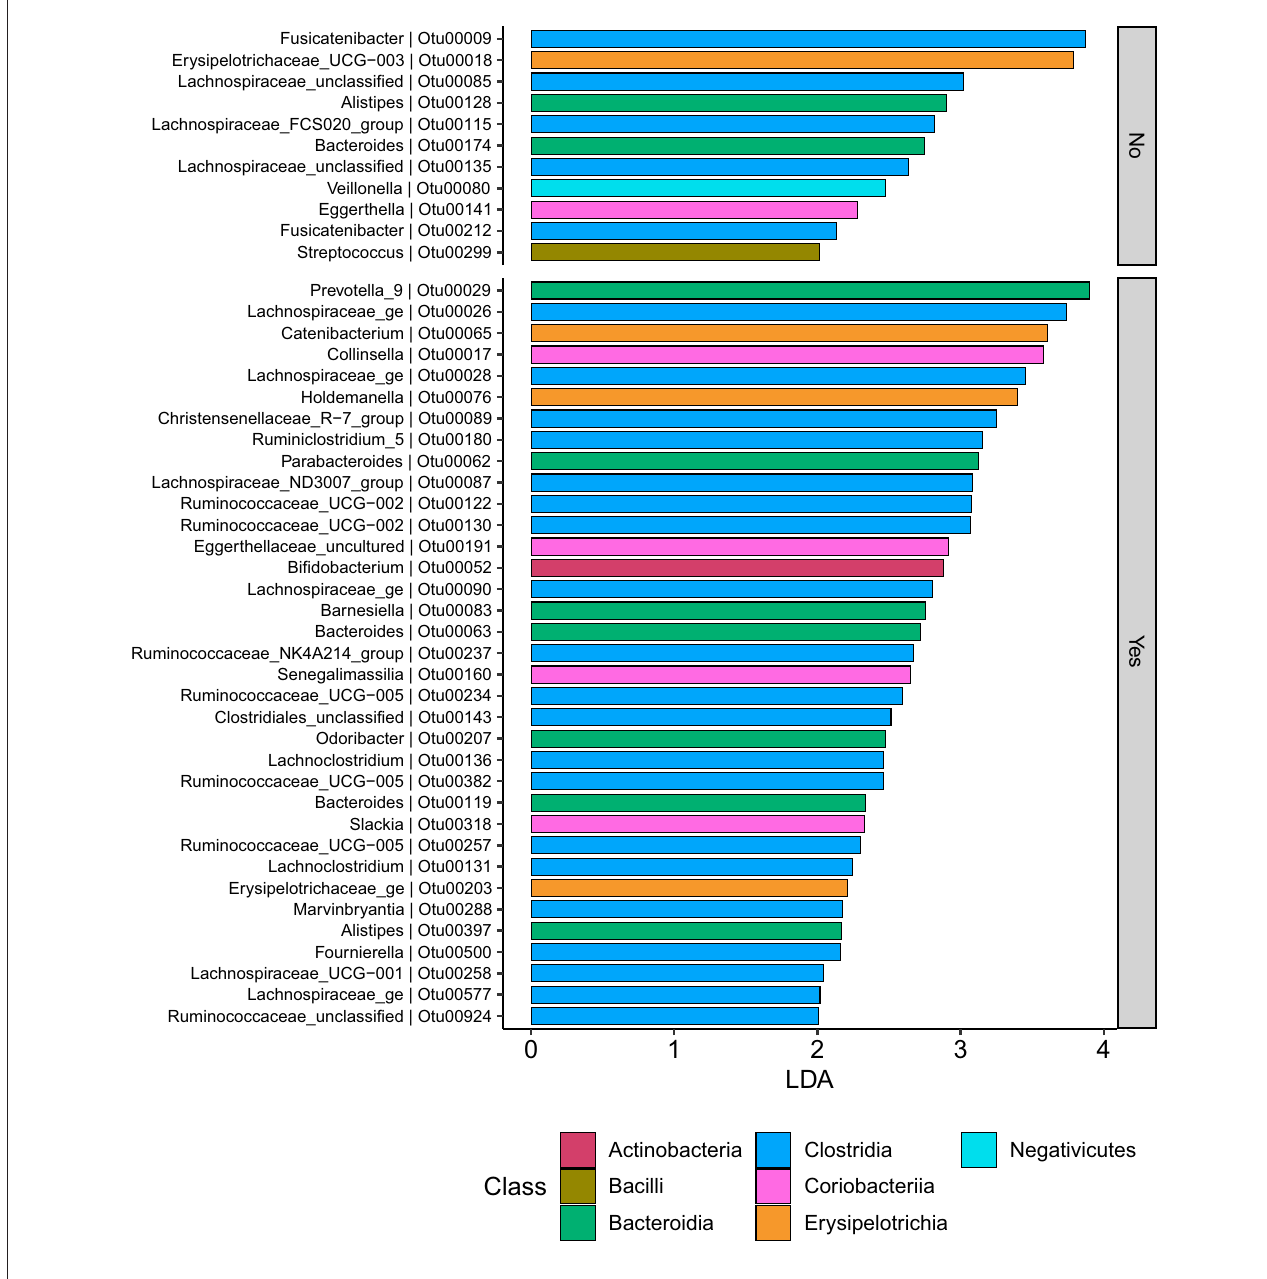
FIGURE 11 | UC participants-Microbial biomarkers. OTUs microbial biomarkers for UC groups with two treatment options (biologic as Yes and non-biologic treatments as No) (OTUs and Genus information on Supplementary Information No. 14).